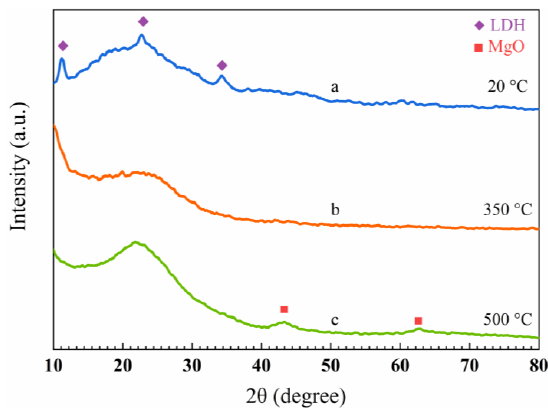
Figure 10. XRD patterns of the LDH/SA-10% by heat treatment at various temperatures, (a) the orig- inal, (b) 350 °C and (c) 500 °C. original, ( b ) 350 ◦ C and ( c ) 500 ◦